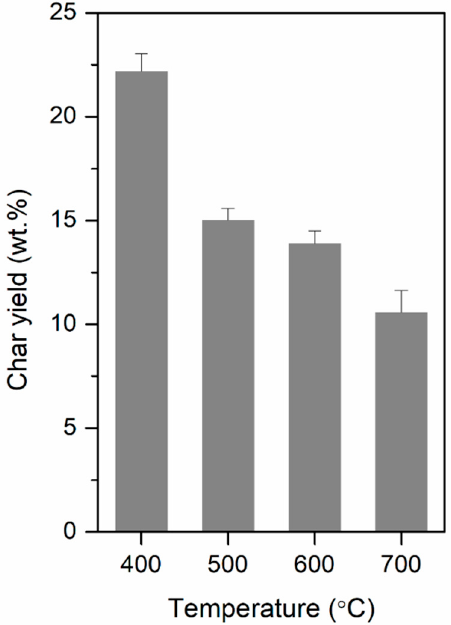
Figure 4. Yield of char (on the basis of the weight of the feedstock) produced via the pyrolysis of TBW at different temperatures. Mean values of replicates ( n = 3) are reported with the standard deviations as error bars.